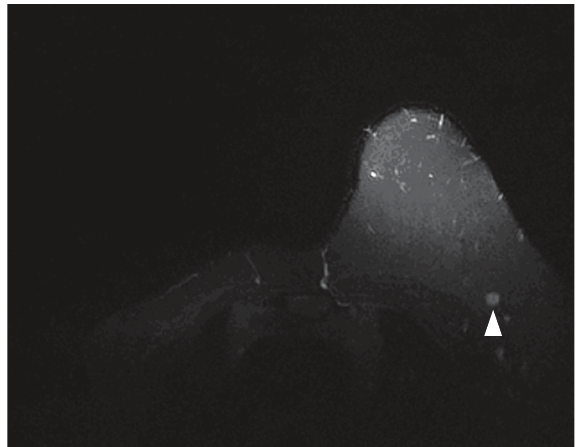
Figure 2: An MRI image demonstrates an axillary reticular mass lesion with T1A hypointense signal intensity changes.